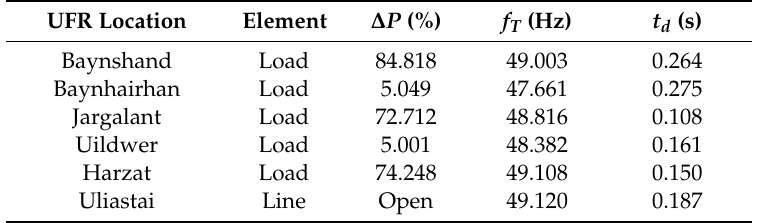
Table 5. Optimal UFLS settings of low inertia—winter season scenario of